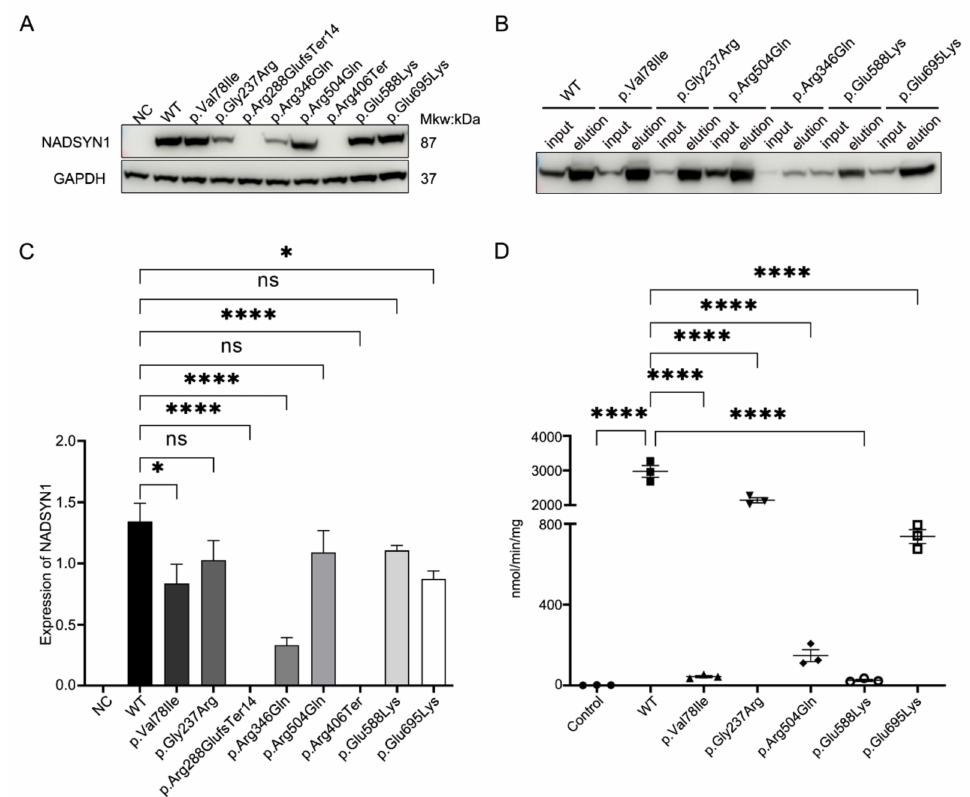
Figure 2. ( A ) Expression of NADSYN1 protein in cells transfected with wild type (WT) and mutant NADSYN1 plasmid. ( B ) The western blot shows the content of the NADSYN1 protein before and after protein purification. ( C )Quantification of the NADSYN1 WT and mutant protein based on western blot results. Then band intensity was measured by ImageJ based on ImageJ software. ( D ) Nicotinamide adenine dinucleotide synthetase activity of purified mutant protein compared to wild-type (WT) NADSYN1 protein. Abbreviations: NC, negative control; ns, non-significant. The results are shown as the mean ± standard error of three independent experiments. p -Values < 0.05 (*), 0.0001 (****) were considered